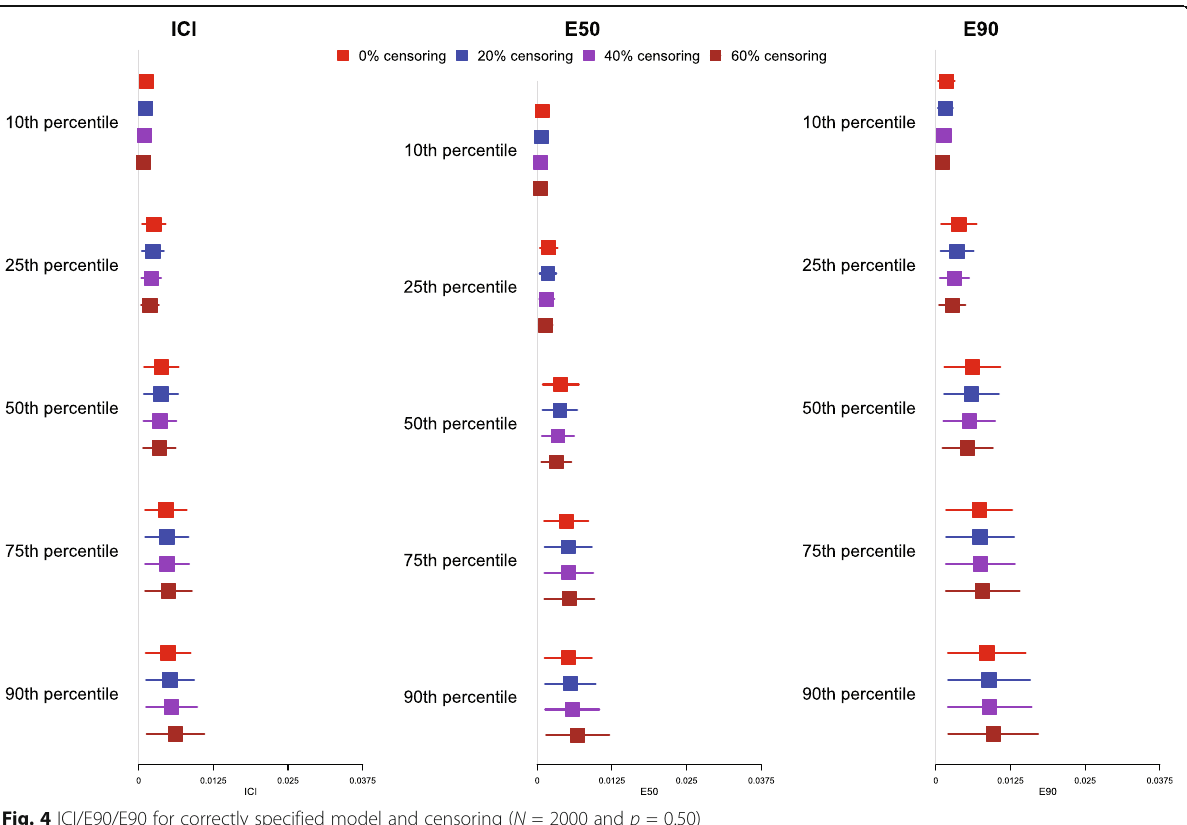
Fig. 4 ICI/E90/E90 for correctly specified model and censoring ( N = 2000 and p =